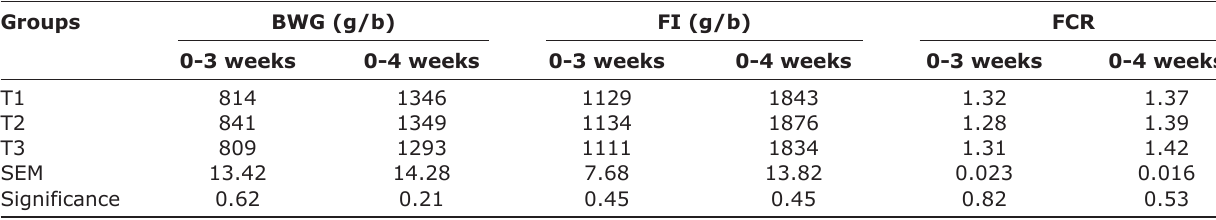
Table-2: Growth performance of broiler chicken.